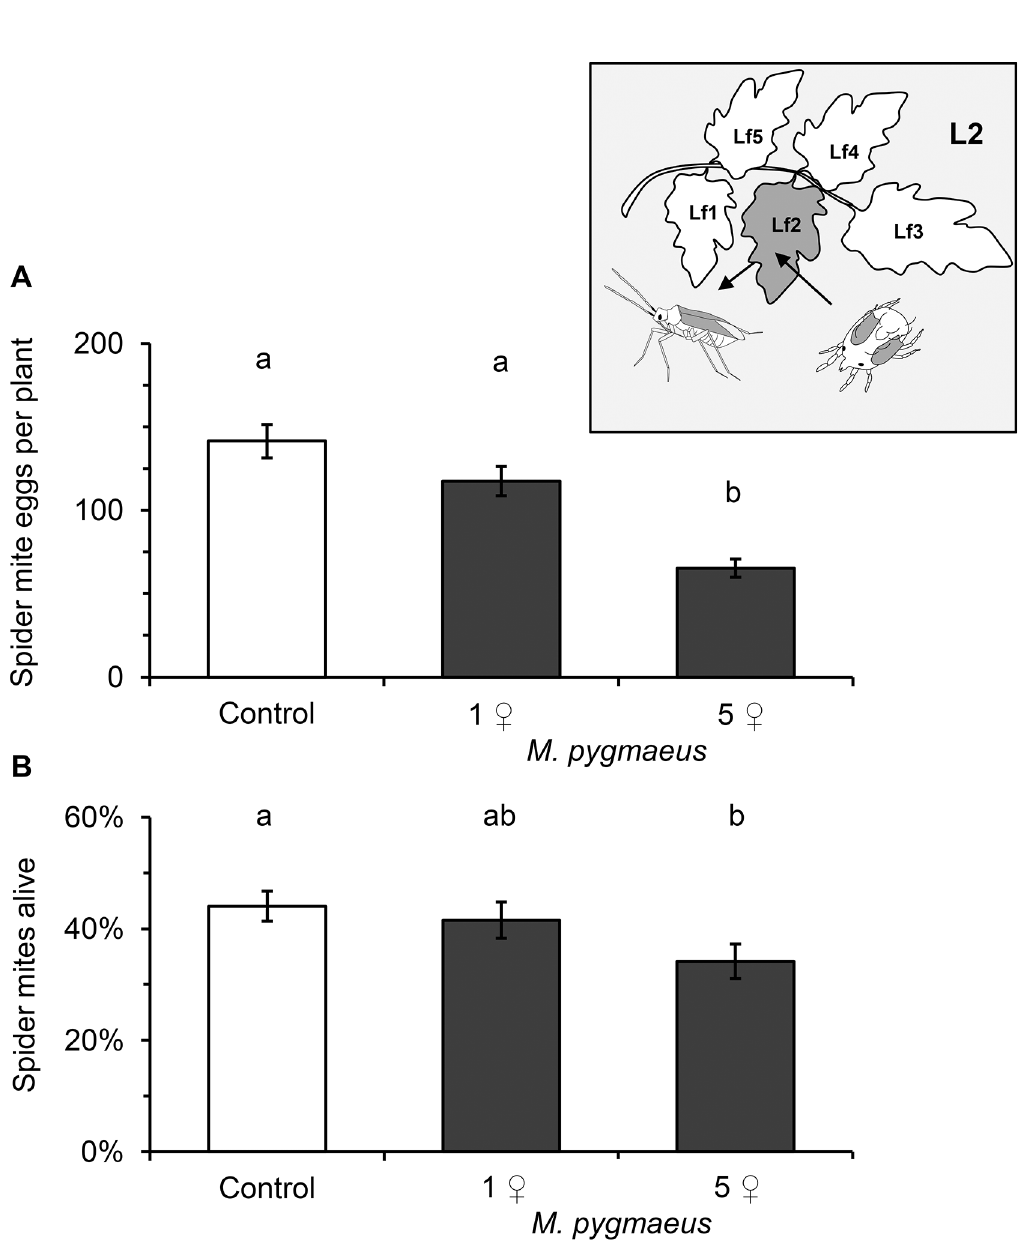
Fig 2. Local plant-mediated effects of Macrolophus pygmaeus on Tetranychus urticae performance. M . pygmaeus females were enclosed in clip cages on the abaxial side of the second oldest leaf (L2) at a defined leaflet (Lf2) for 4 days before 10 young T . urticae females were kept on the same leaflet without access to the area pre-exposed to M . pygmaeus (inset). (A) Number of eggs per plant and (B) proportion of alive T . urticae females on the same leaflet that was previously exposed to 1 (38 plants) or 5 (36 plants) female predators (dark bars) or the corresponding leaflets of (37) control plants (white bars) (mean +/- S.E., plants, in three blocks). Significant differences between exposed plants and control plants are indicated by different letters by Tukey contrasts following a